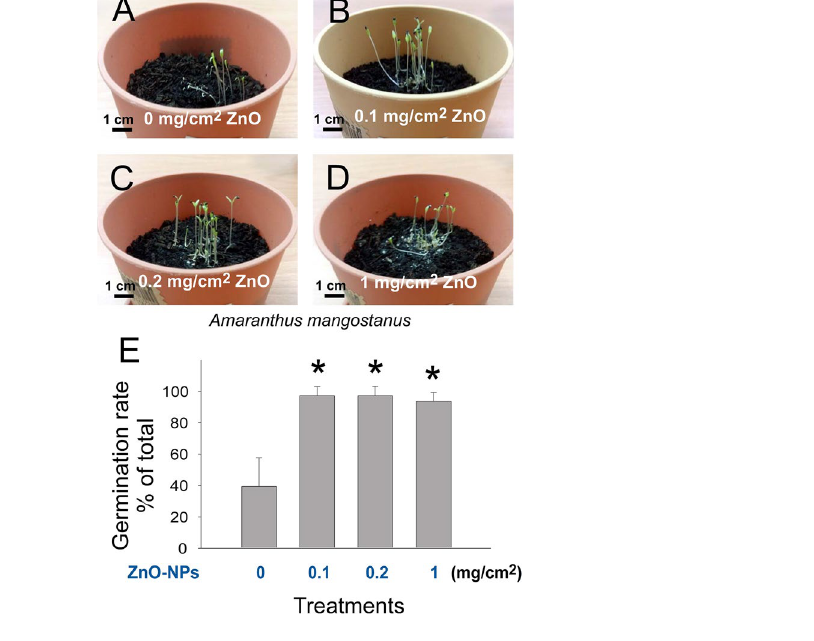
Figure 3. Treatments of ZnO NPs on soil enhanced the germination rate of Amaranthus mangostanus seeds. Images of 1-week-old seedlings of Amaranthus mangostanus after seeding on soil without ( A ) or with ( B–D ) the addition of ZnO NPs are shown. The seed germination rates of aforementioned conditions were quantified ( E ). * P < 0.05 vs. 0 mg/cm 2 ZnO untreated groups. n = 3 (3 independent experiments; each experiment with 30 seeds). ( A–D ) Pot diameter: 10 cm; scale bars: 1